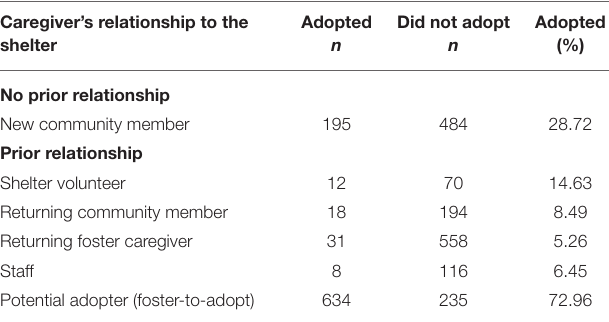
TABLE 8 | Adoption of fostered dogs and puppies by caregiver’s relationship to the shelter. Caregiver’s relationship to the